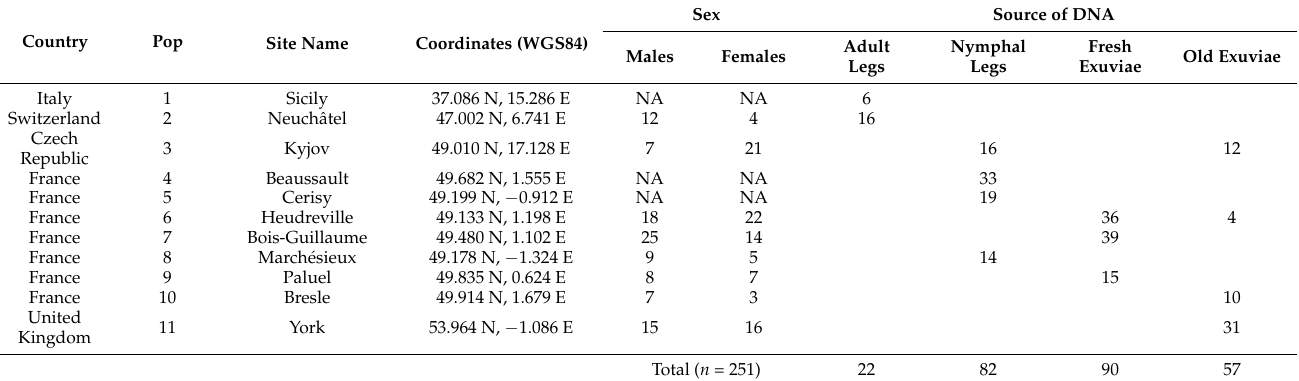
Table 1. Details on the 11 localities where populations of Anax imperator that were studied in Europe and the number of collected samples according to their source of DNA. NAs indicate no information on sex